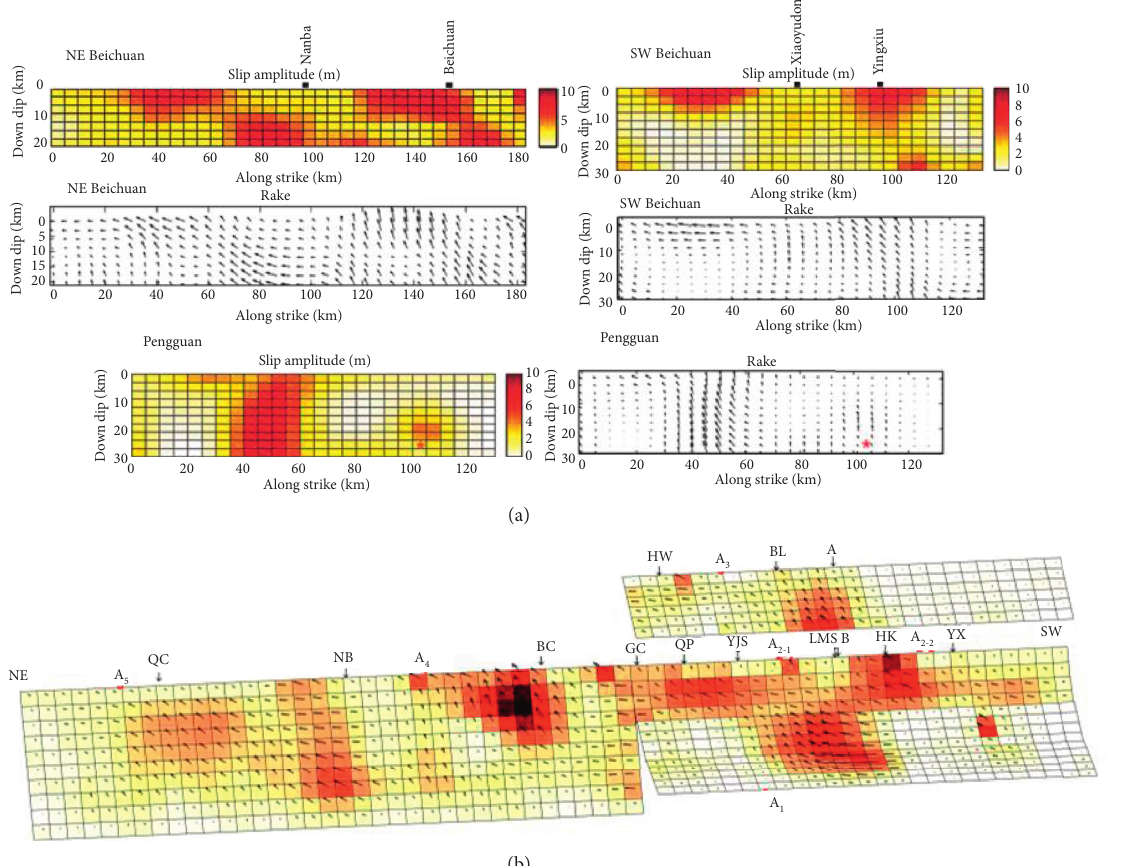
Figure 11: The inversion result of teleseismic data [1] (a) and this article